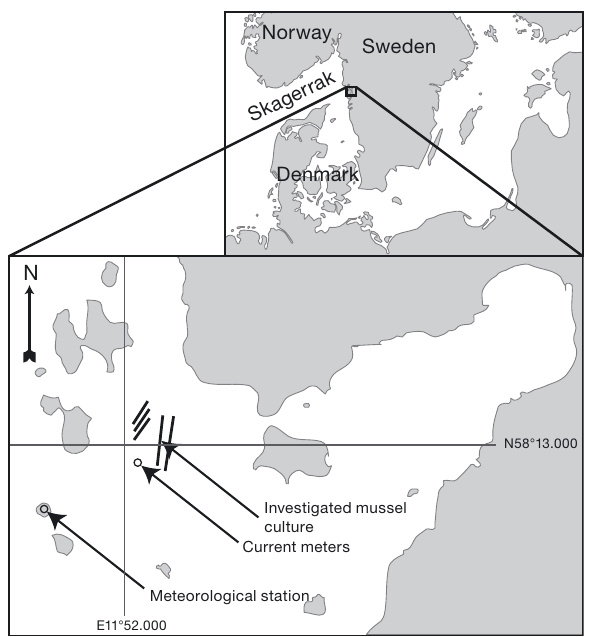
Fig. 1. Positions of the meteorological station and current meters in Ljungskile bight, western Sweden, during the campaign period. Each line on the lower map represents a mussel culture